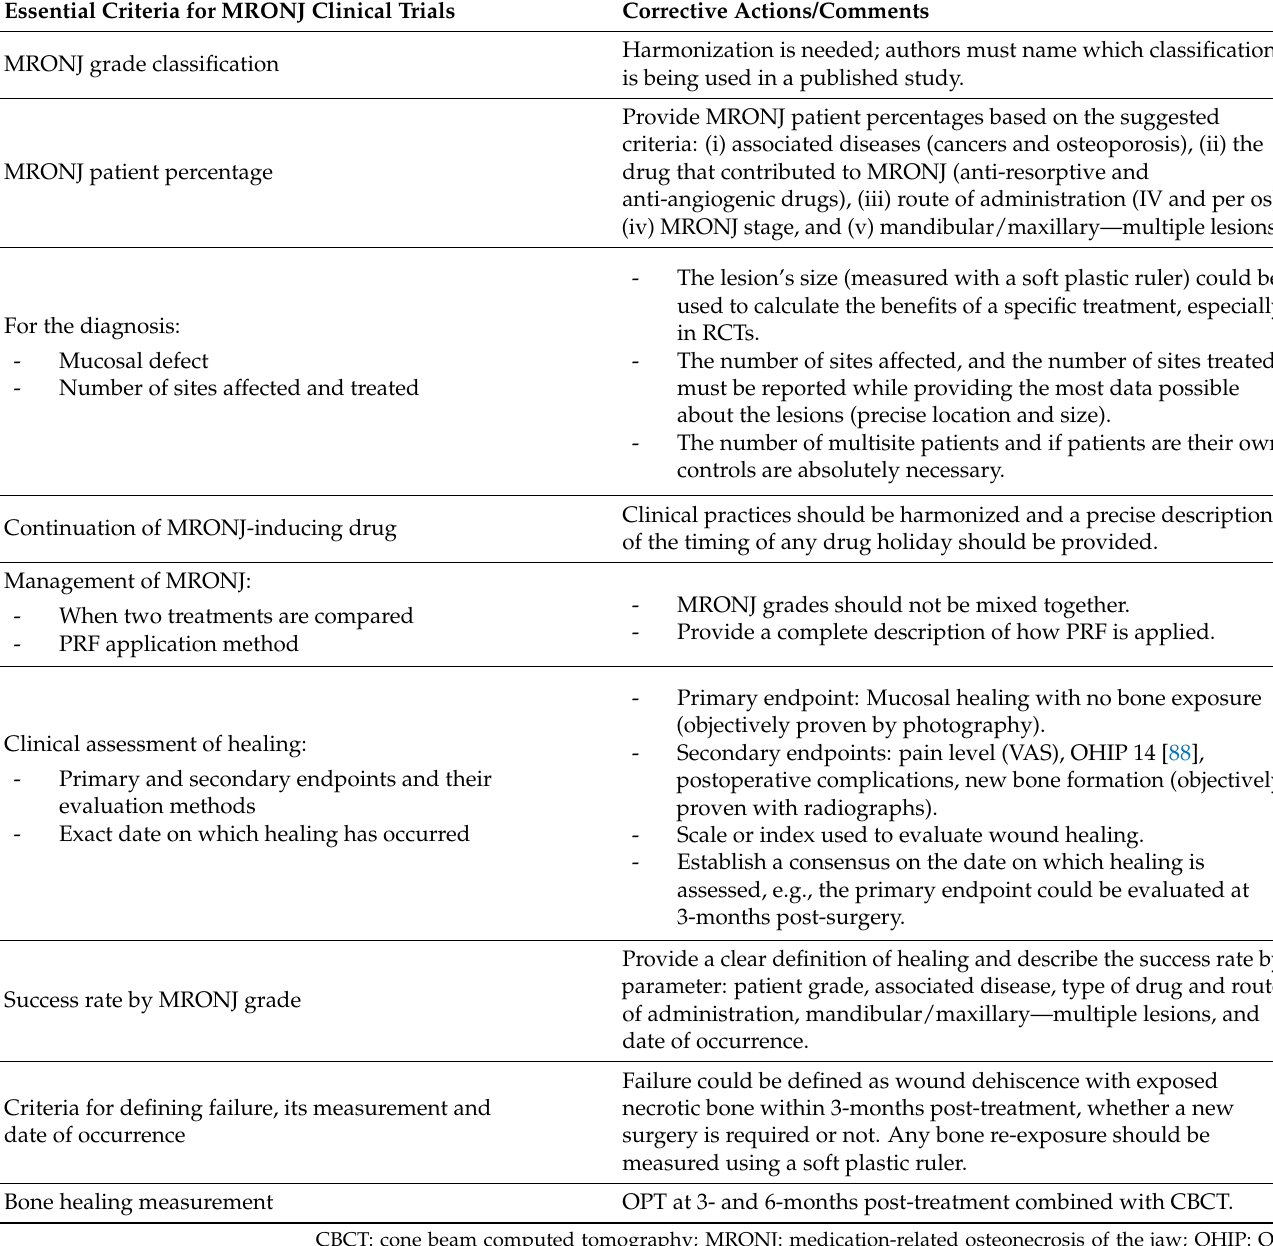
Table 1. Critical information to be included in future clinical trials on